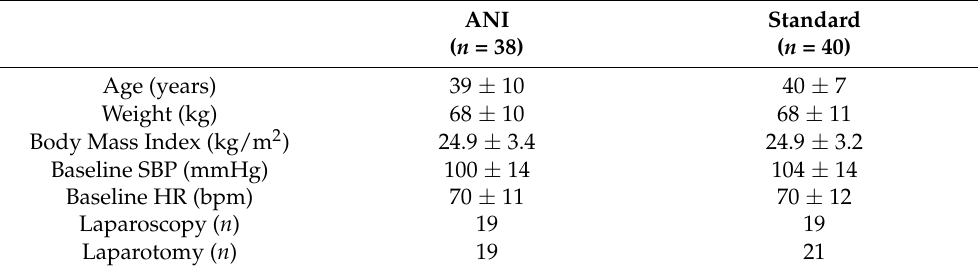
Figure 1. CONSORT flow diagram. Table 1. Patient characteristics. Baseline measurements were made under general anesthesia, just before surgical incision. Data are presented as mean ± standard